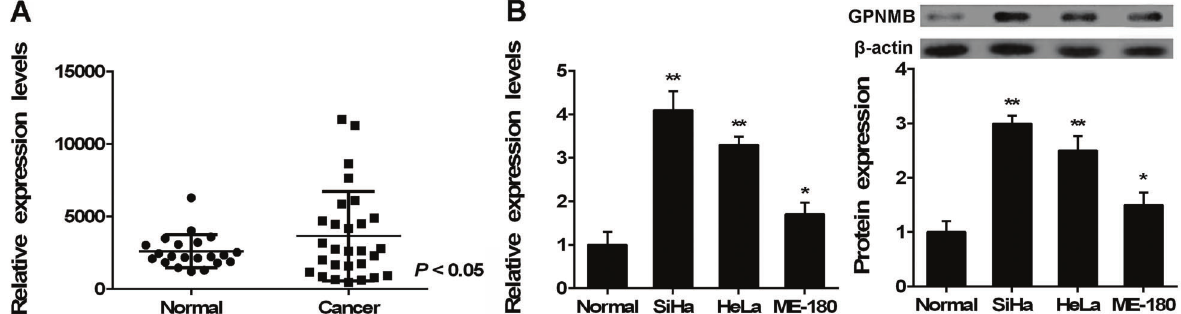
Figure 1 . A , Expression of glycoprotein nonmetastatic melanoma protein B (GPNMB) in human cervical cancer patients as well as in normal cervix epithelium from GEO database. B , RT-PCR and western blot assay were performed to evaluate the mRNA and protein expressions of GPNMB in human cervical cancer cells SiHa, HeLa, and ME-180 cells, as well as in normal cervical epithelial cells. Data are reported as means ± SE. *P o 0.05, **P o 0.01 vs Normal (ANOVA).